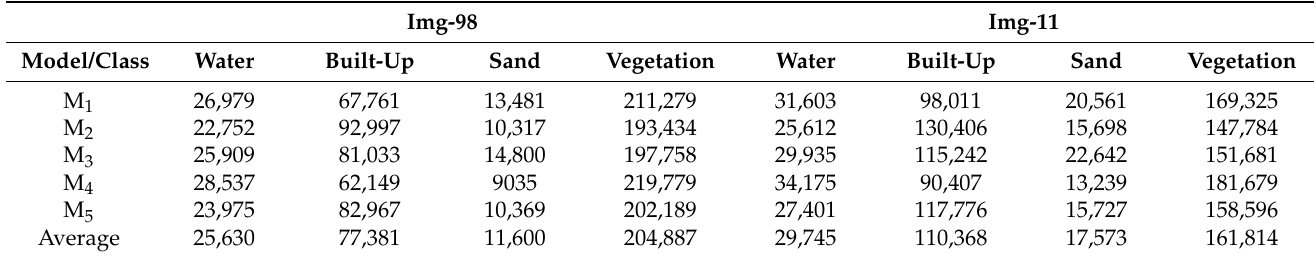
Table 6. Class-wise number of pixels identification using top five machine learning models.